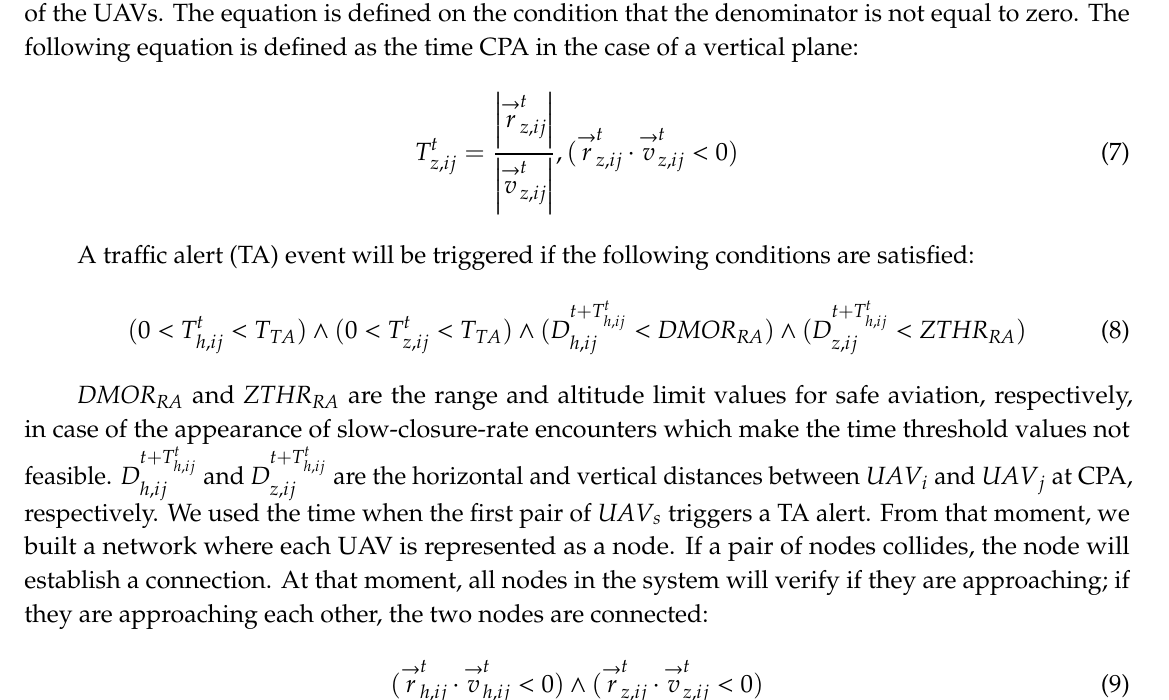
Figure 2. Conceptual graph for key node selection.